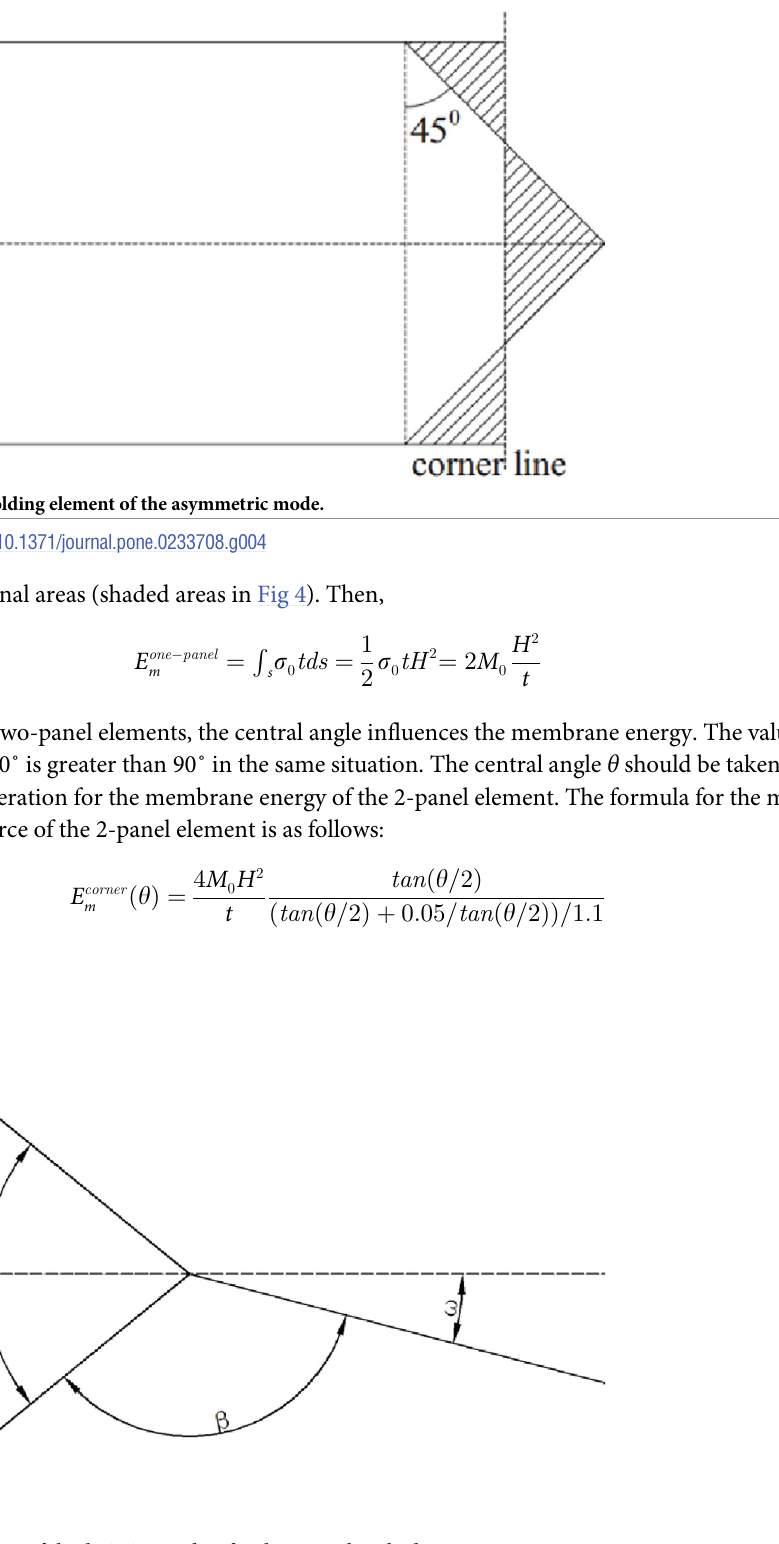
Fig 5. Definition of the deviation angle ω for three-panel angle element